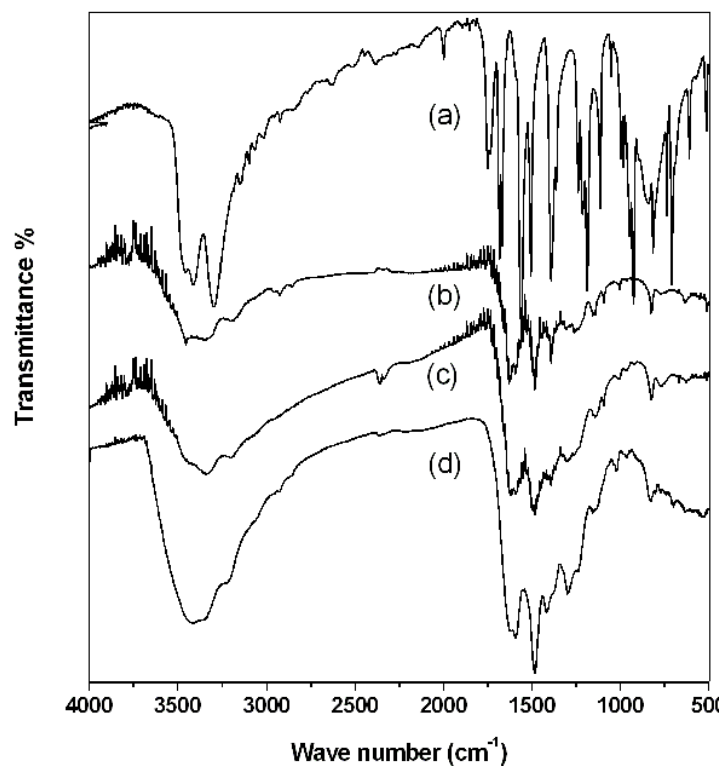
Figure 5. FTIR absorption spectra: ( a ) Monomer 1 ; ( b–d ) PAPy: ( b ) DP = 3; ( c ) DP = 7; ( d ) DP = 64.